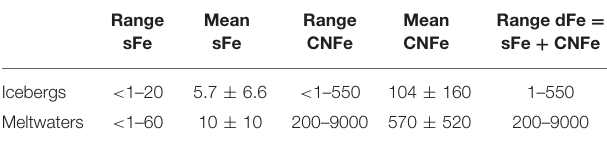
TABLE 1 | Explanation of the terminology used. TABLE 2 | Means and ranges of sFe and CNFe in icebergs and meltwaters